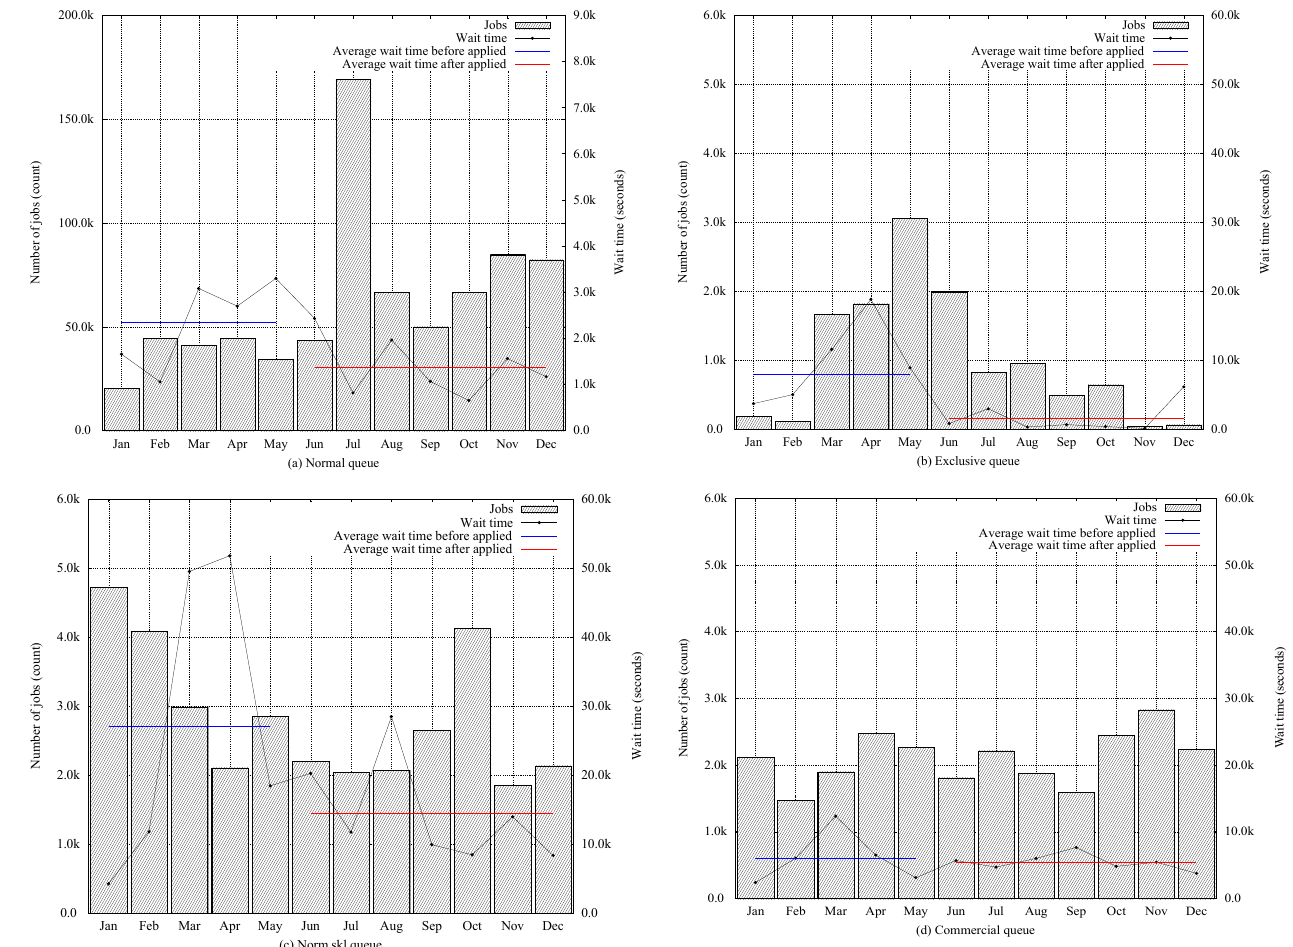
Figure 6. Comparison of the waiting time before and after applying K-hook with scheduling by main queues. ( a ) Normal queue and ( b ) exclusive queue in KNL type. ( c ) Norm_skl queue and ( d ) commercial queue in SKL type.